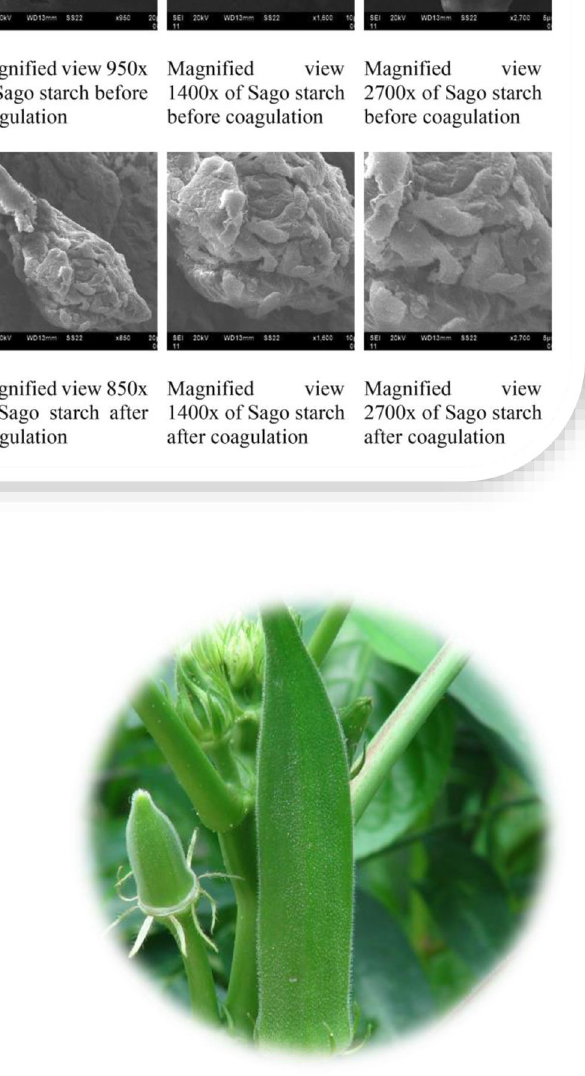
Fig. 14 gums of Hibiscus esculentus as